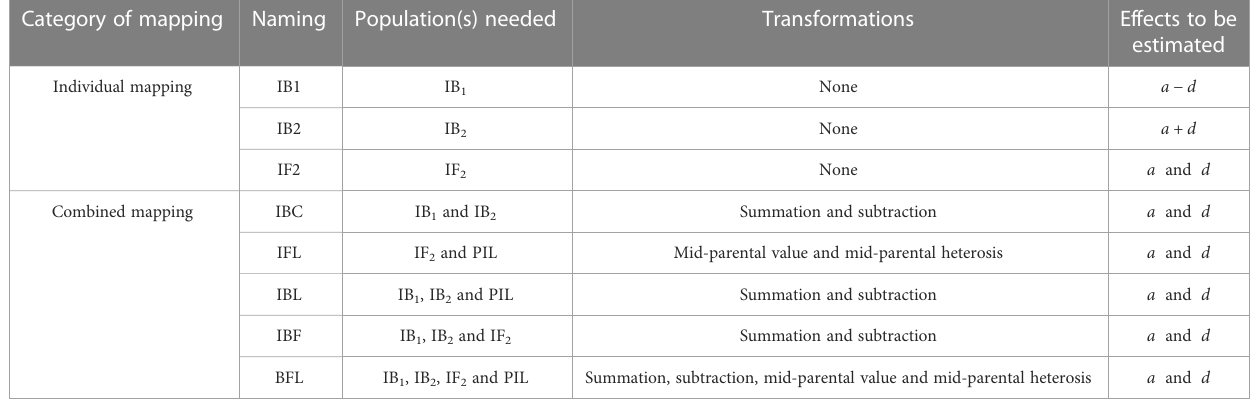
TABLE 3 Naming and properties of individual and combined QTL mappings, depending on available populations. Category of mapping